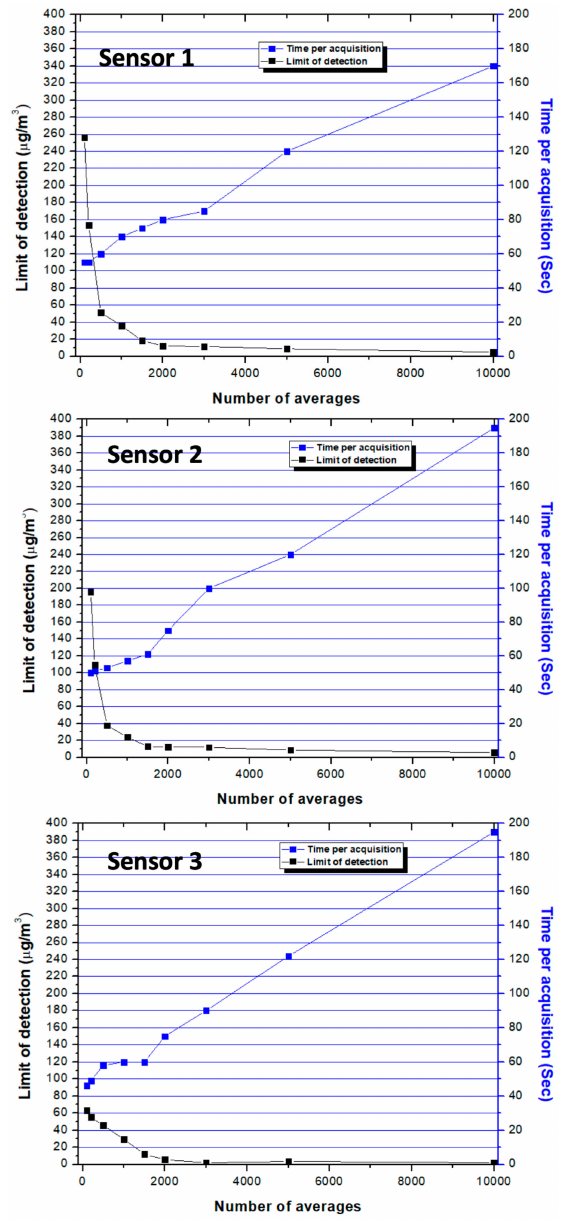
Figure 4. The e ff ect of number of LED pulses averaged (N) on the limit of detection (black squares) for sensors 1–3. The second y-axis (blue) presents the seconds required to acquire and report data for the specified number of